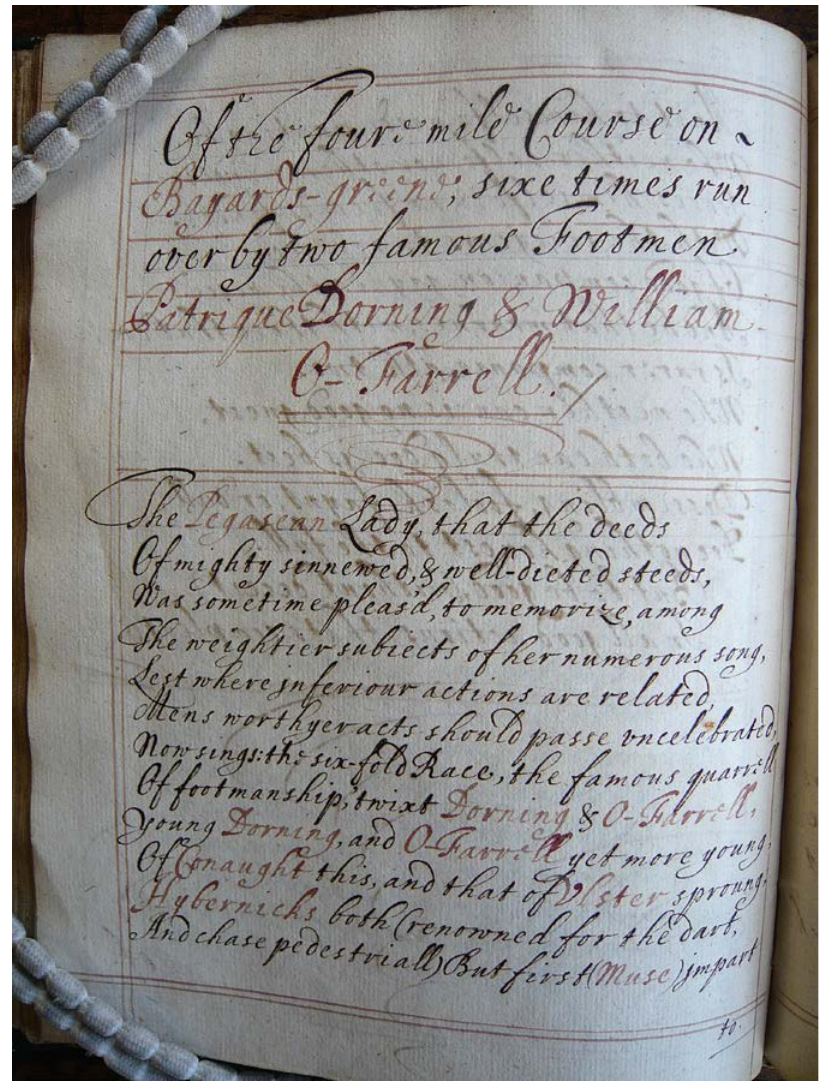
Fig. 4 - Title of the collection’s final poem, describing ‘the two famous Footmen Patrique Dorning & William O-Farrell’, f.